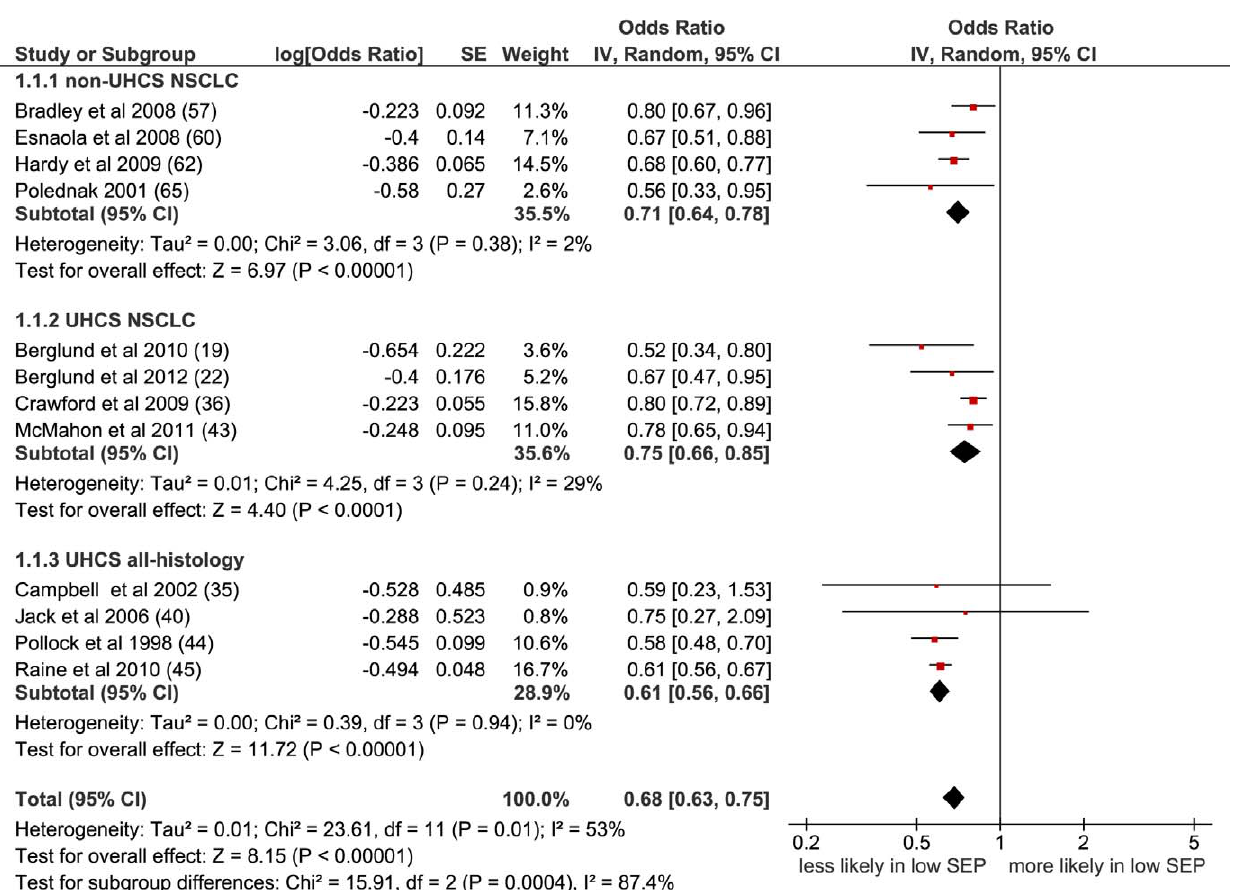
Figure 2. Meta-analysis of odds of receipt of surgery in low versus high SEP. CI, confidence interval; non-UHCS, non-universal health care system; NSCLC, non-small cell lung cancer; OR, odds ratio; SE, standard error; SEP, socioeconomic position; UHCS, universal health care system.